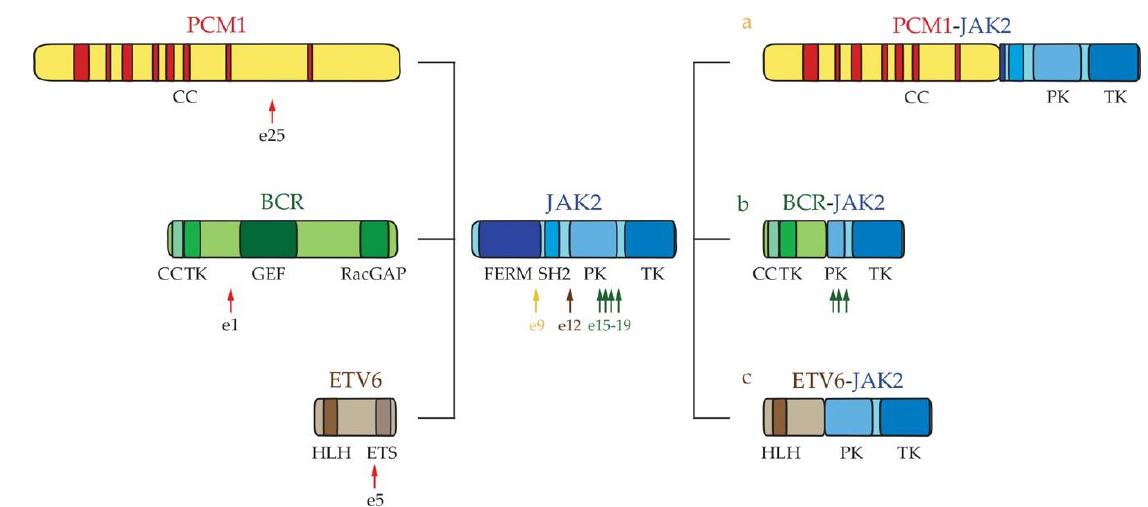
Figure 4. Schematic representation of JAK2 fusion rearrangements. ( a ) PCM1-JAK2 ; ( b ) BCR-JAK2 ; and, ( c ) ETV6-JAK2 . The arrows indicate the position of breakpoints of JAK2. BCR = breakpoint cluster region; CC = Coiled Coil; GEF = Guanine Nucleotide Exchange Factor; ETS = (Erythroblast Transformation Specific) DNA-binding domain; HLH = Helix-Loop-Helix oligomerization domain; FERM = 4.1 ezrin, radixin and moesin domain; JAK2 = janus kinase 2; PCM1 = Pericentriolar Material 1; PK = Pseudo kinase domain; RacGAP = COOH-terminal GTPase Activating Protein (GAP) domain; SH2 = Src-homology-2 domain; TK = Tyrosine Kinase.